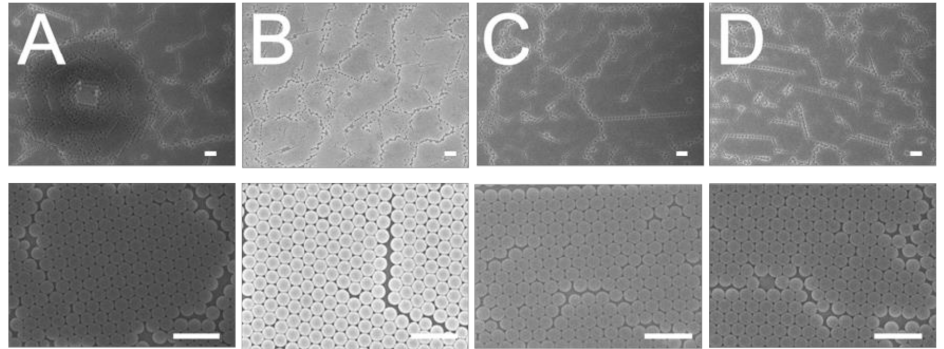
Figure 5. Influence of spin time on the assembly of 300 nm nanosphere arrays, ( A ) 20 s, ( B ) 30 s, ( C ) 40 s, ( D ) 50 s (disperant percentage was 10% and spin speed was 3000 rpm. Scale bar: 1 µ m; Magnification: top—6000 × , bottom—25,000 × ).